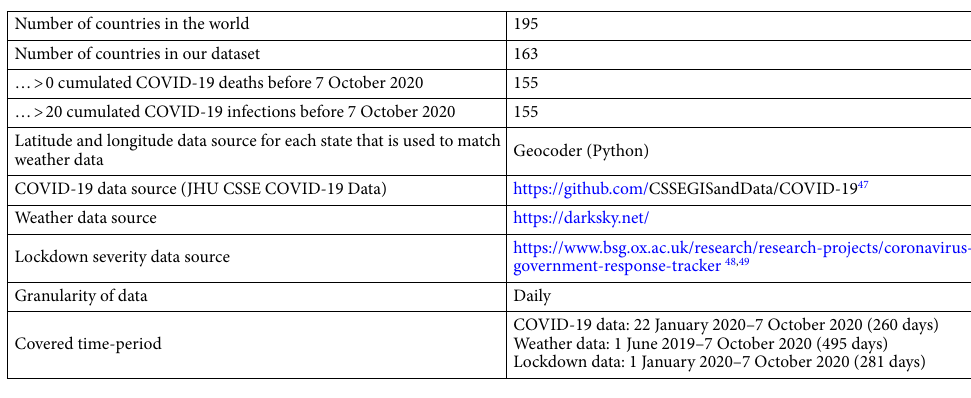
Table 1. Summary of